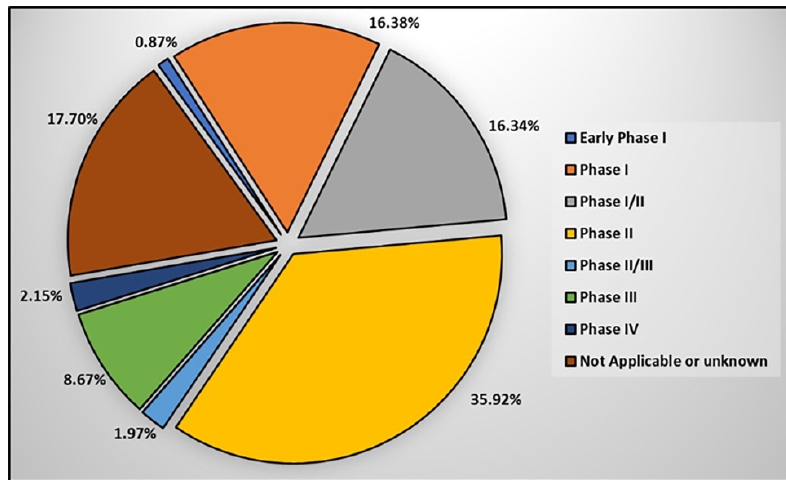
Figure 4. Status of clinical phase within clinical trials using stem cells.